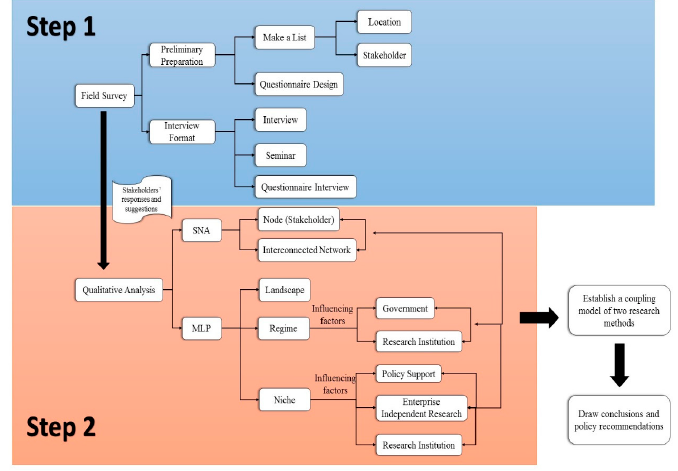
Figure 1. The research framework.